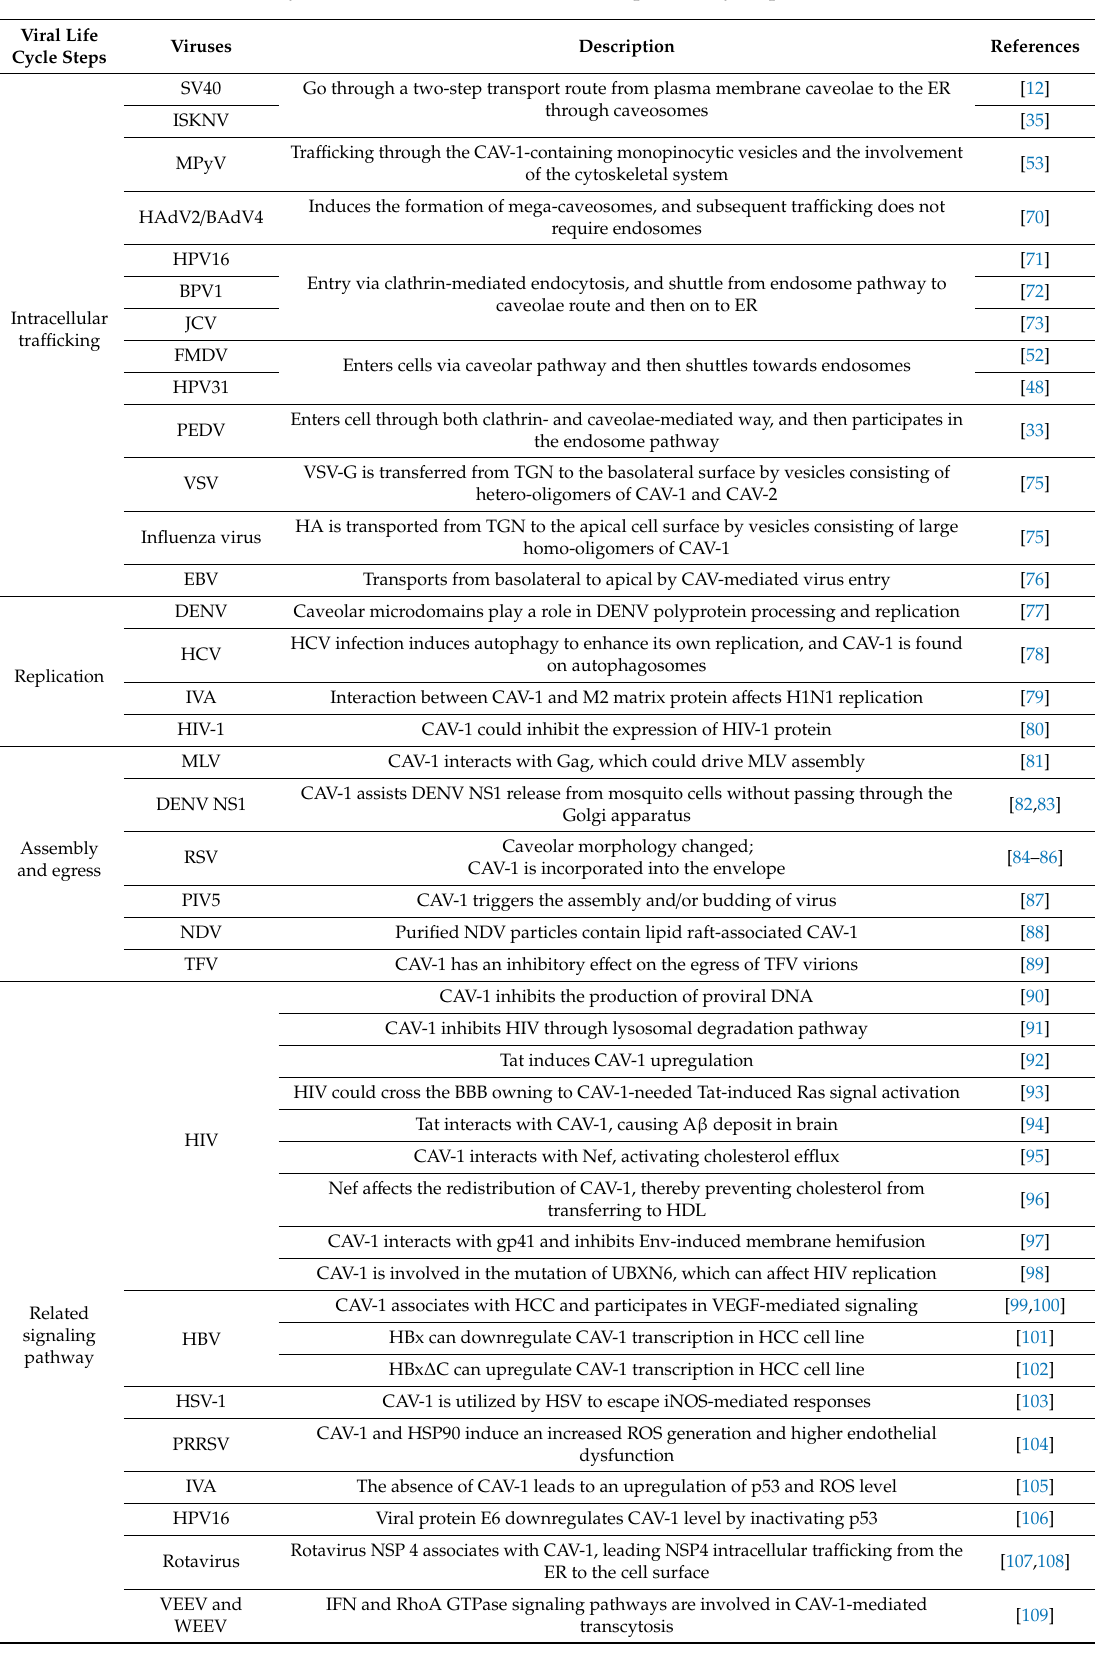
Table 2. Summary of the roles of caveolae / CAV-1 in post-entry steps of virus infection. Viral Life Cycle